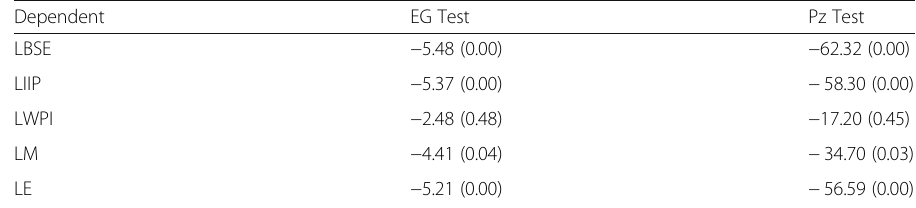
Table 5 Conventional Cointegration Test for ACE Transformed Variables Dependent EG Test Pz Test LBSE − 5.48 (0.00) − 62.32 (0.00) LIIP − 5.37 (0.00) LWPI LM − 4.41 (0.04) − 34.70 (0.03) LE − 5.21 (0.00) − 56.59 (0.00)